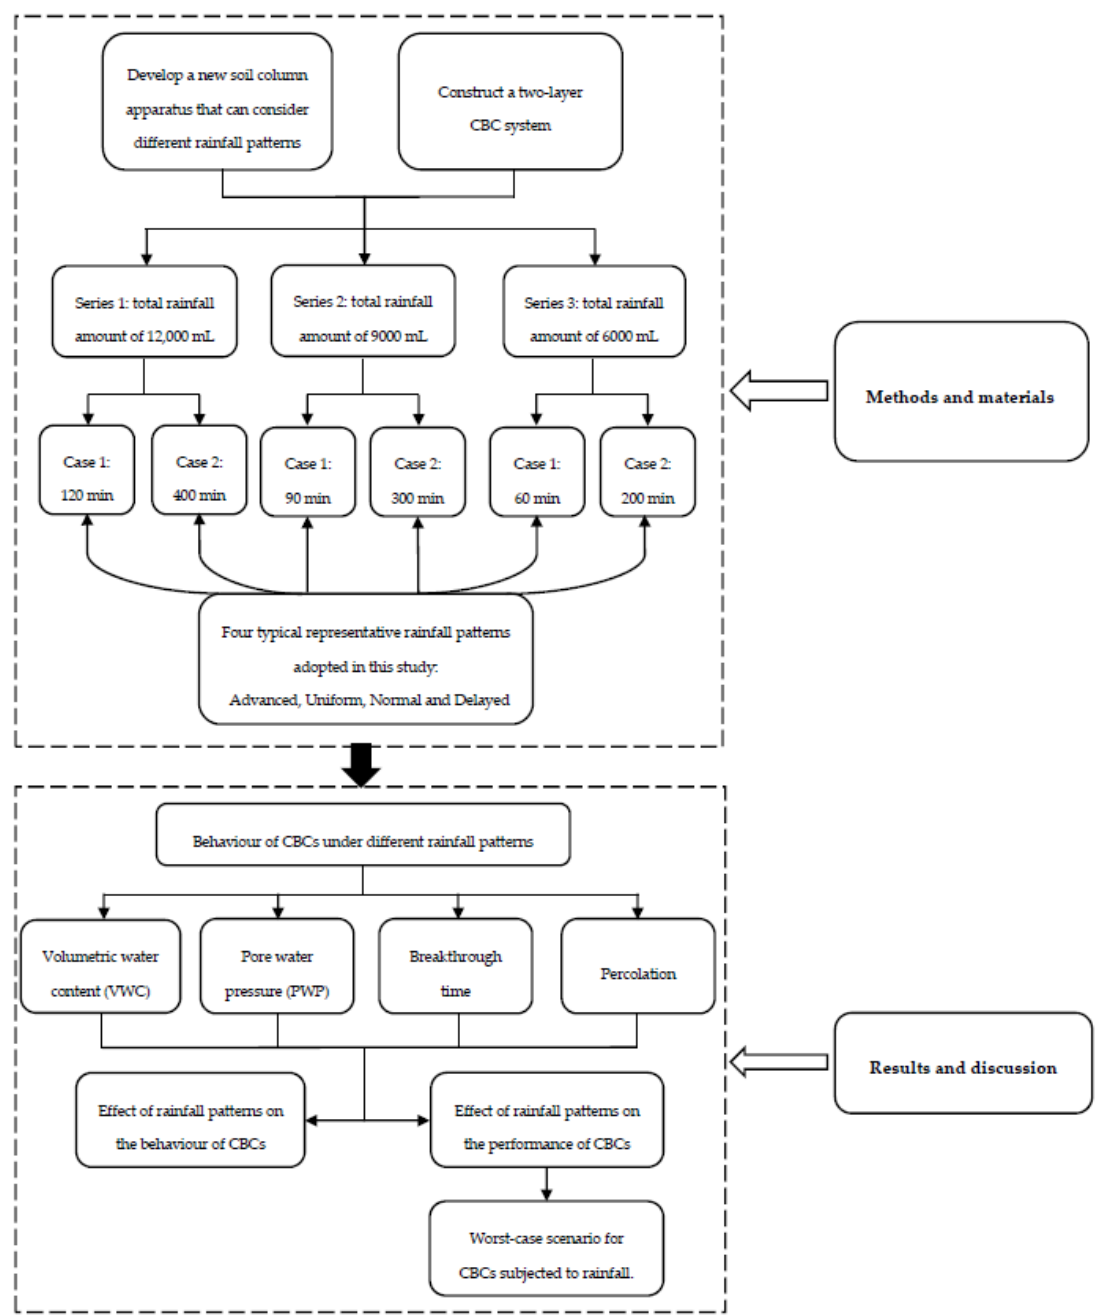
Figure 1. Procedure of this study.